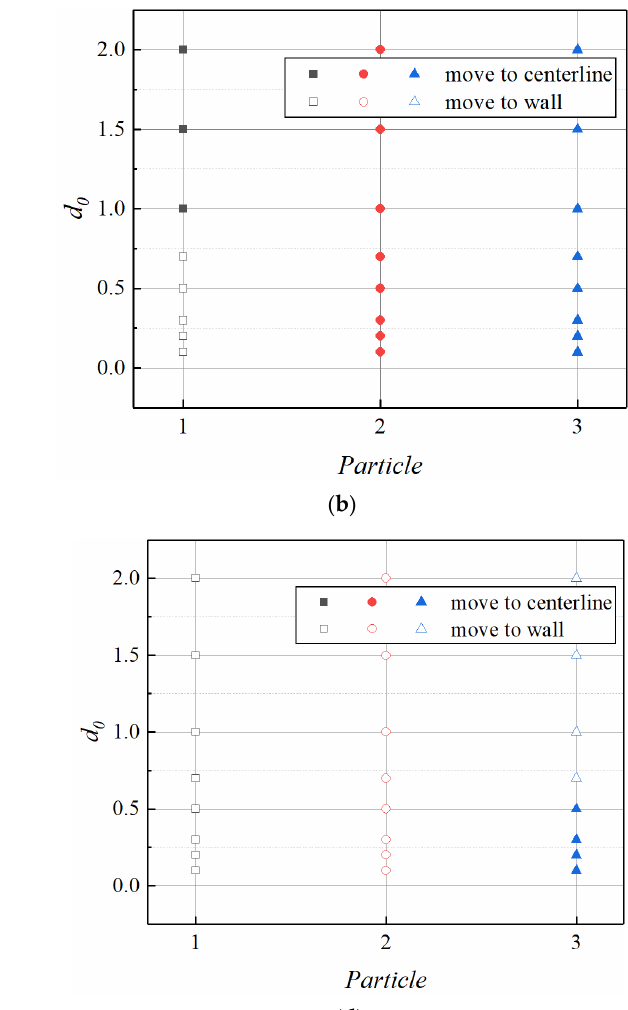
17 of 21 Figure 14. Direction of particle migration for different particle initial positions and mobility parameters. ( Wi = 0.5, η r = 0.3, ε = 0.3).